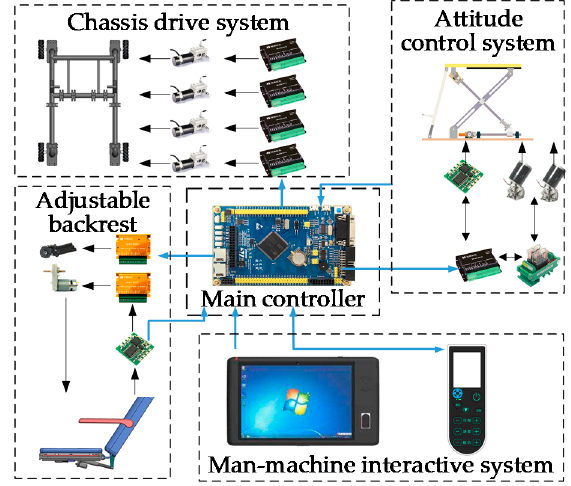
Figure 15. Intelligent toilet wheelchair control system.